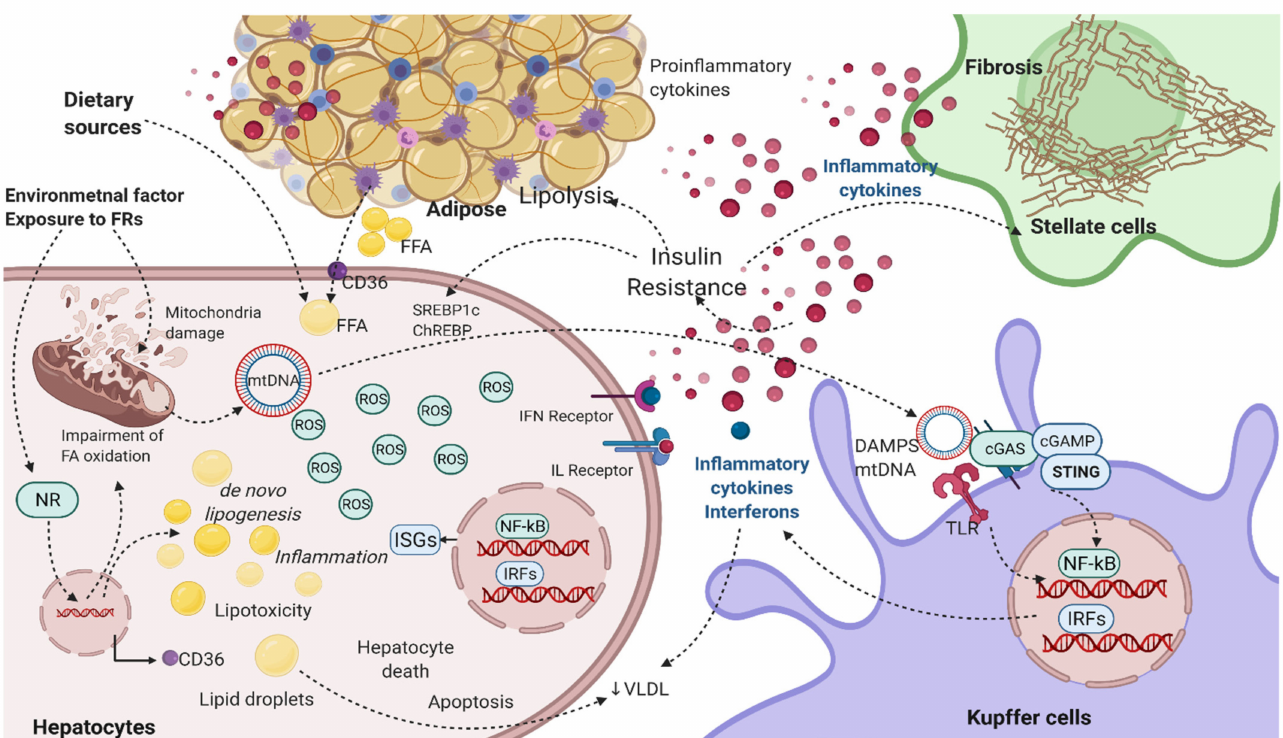
Figure 4. Schematic of FRs-mediated proposed mechanisms and pathways involved in the pathophysiology and progression of NAFLD. FRs, through several distinct mechanisms, could cause biochemical disruptions of many metabolic processes. FRs can induce direct mitochondrial damage or impair the mitochondria function and β -oxidation, thereby inducing ROS and inflammatory signaling. Alternatively, FRs could activate the NXRs. Since NRs are the central regulators of hepatic lipid metabolism, activation of NXR such as PXR could increase lipogenic gene expression, leading to increase de novo lipogenesis, inhibition of fatty acid β -oxidation, and increases in fatty acid import through upregulation of CD36. The impairment of mitochondrial β -oxidation induces the long-chain fatty acids metabolism via peroxisomal β -oxidation and ω -oxidation in the cytochromes. These processes further generate a considerably high amount of ROS, promoting oxidative stress, in turn inducing damage to the mitochondrial membranes, compromising cellular respiration and metabolism, and impairing liver function by cellular damage. Damaged mitochondria release the mtDNA into the cytosol, where it gets recognized as DAMPs by several PRR such as TLR or cGAS. cGAS is an innate immune sensor, which generates a second messenger cGMP and activates STING by translocating it to the perinuclear Golgi complex and serves as a signal for TBK1 and IKK. This promotes the phosphorylation and nuclear translocation of IRF3 and NF- κ B inhibitor I κ B α , and stimulation of IFN, whereas NF- κ B translocation to the nucleus activates pro-inflammatory cytokines. In comparison, TLR activates either MyD88-dependent or TRIF-dependent signaling pathways and induces the expression of various inflammatory cytokines (TNF α , IL-1 β , IL-6, IFNs). Cytokines, e.g., IFNs, bind to their respective receptors and initiate the downstream signaling, which phosphorylates and activates the transcription factors and initiates transcription of several IFN-related genes responsible for insulin resistance and activation of inflammatory mediators and de novo lipogenesis. Insulin resistance stimulates hyperinsulinemia, which increases glycolysis and promotes de novo lipogenesis by enhancing ChREBP and SREBP-1c, significantly contributing to lipid accumulation. Insulin resistance increases lipolysis, leading to increased free fatty acids delivery from the peripheral organs into the liver mediated by elevated CD36. Inflammatory mediators, such as IFNs, TNF α , and IL-6, may further decrease VLDL export and facilitate lipid accumulation. The net result is an escalation of hepatic steatosis and inflammatory condition, eventually leading to more severe NAFLD/NASH conditions. (Created using